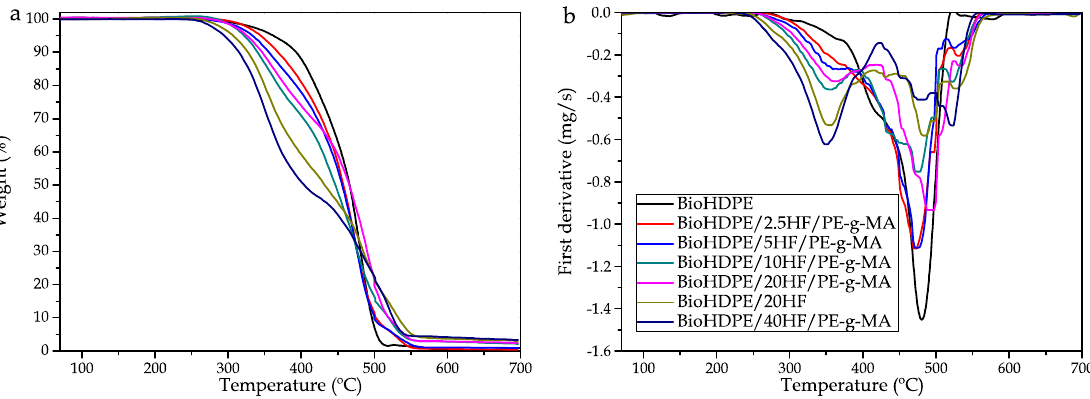
Figure 6. Thermal degradation of BioHDPE/Hemp fiber composites: ( a ) thermogravimetric (TGA) curves and ( b ) first derivative (DTG) curves. Table 5. Main thermal degradation parameters of the composites with different amounts of hemp fiber in terms of: Temperature at mass loss of 5% (T 5% ), degradation temperature (T deg ), and residual mass at 700 °C.